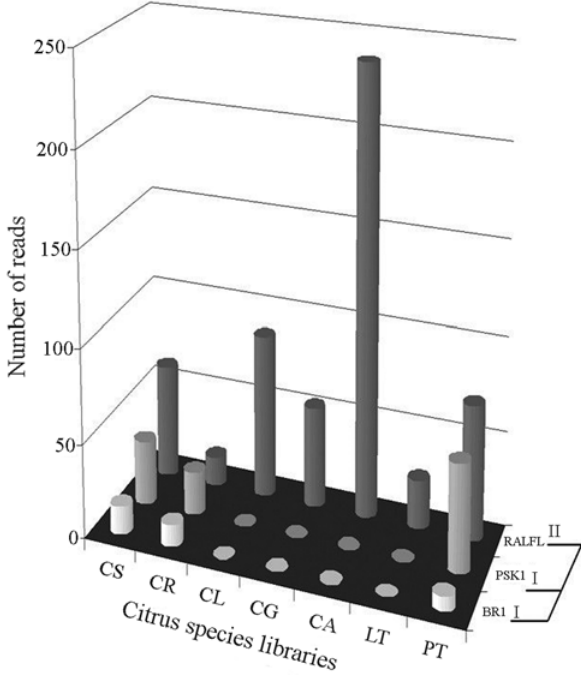
Figure 5 - Differential expression of peptide hormones in citrus species. The normalized number of reads for the transcripts in each library is repre- sented in the y-axis. Citrus species libraries are represented by two-word abbreviations (CS, C. sinensis ; CR, C. reticulata ; CL, C. limonia ; CG, C. aurantifolia ; CA, Citrus aurantium; LT, C. latifolia; PT, Poncirus trifoli- ata ). Hierarchical clustering of the expression patterns is represented by Roman